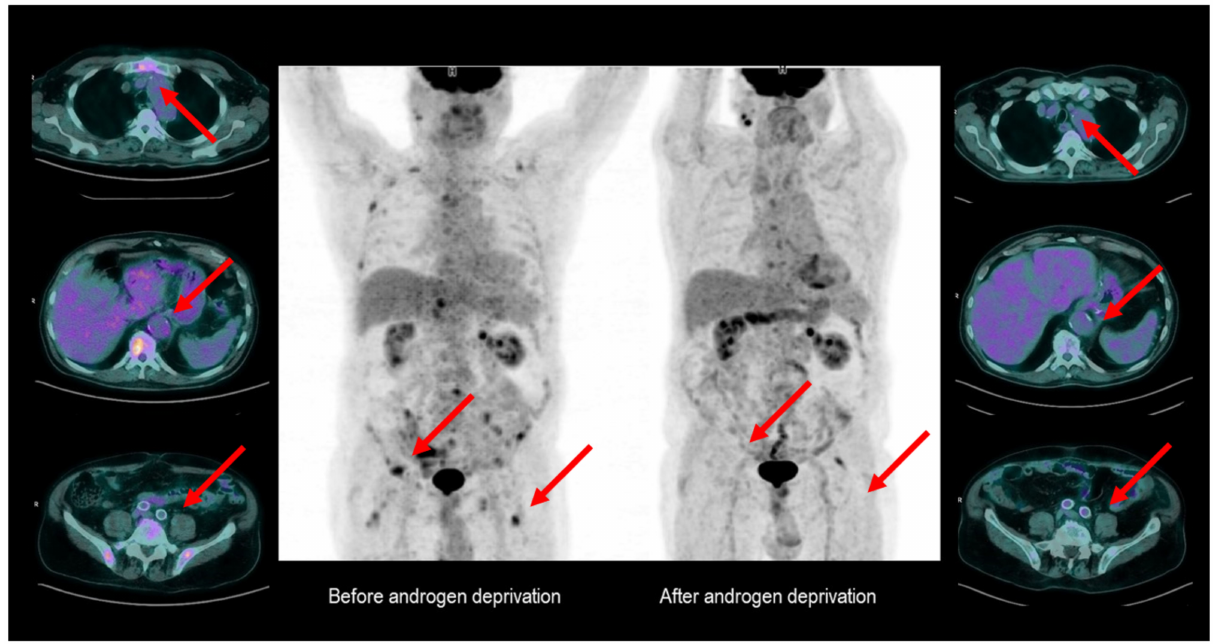
Figure 4. Androgen deprivation-induced metabolic response in hormone-sensitive PCa. The red arrows indicate metabolically active